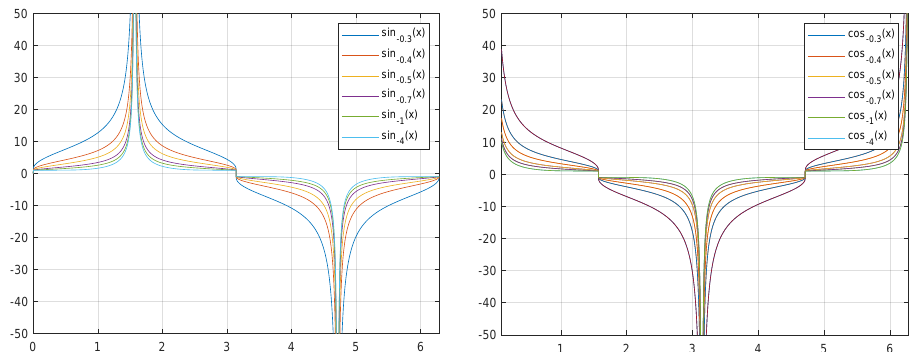
Figure 6. The p -generalized sine and cosine functions, p < 0. For figures in case p > 0, see [7]. The jumps that are seen in multiples of π /2 occur from +1 to − 1, or vice versa.